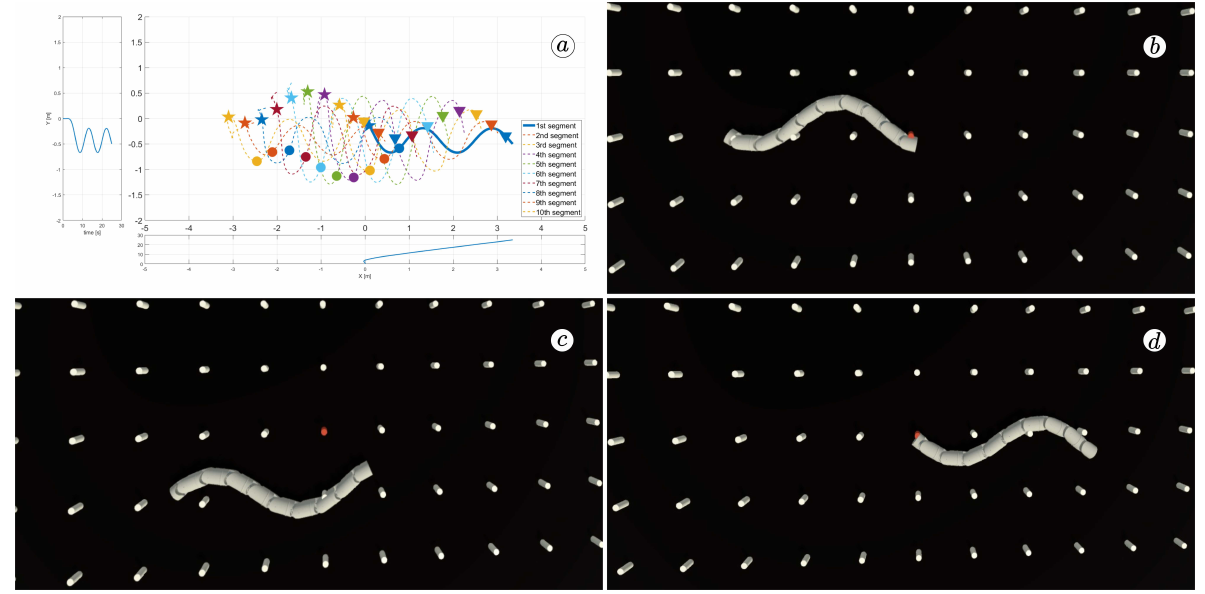
Figure 9. Trajectories of robot segments for c t = 1 and c n = 10 ( a ) and robot configurations for t = 5 ( s ) ( b ), t = 10 ( s ) ( c ), and t = 24 ( s ) ( d ).